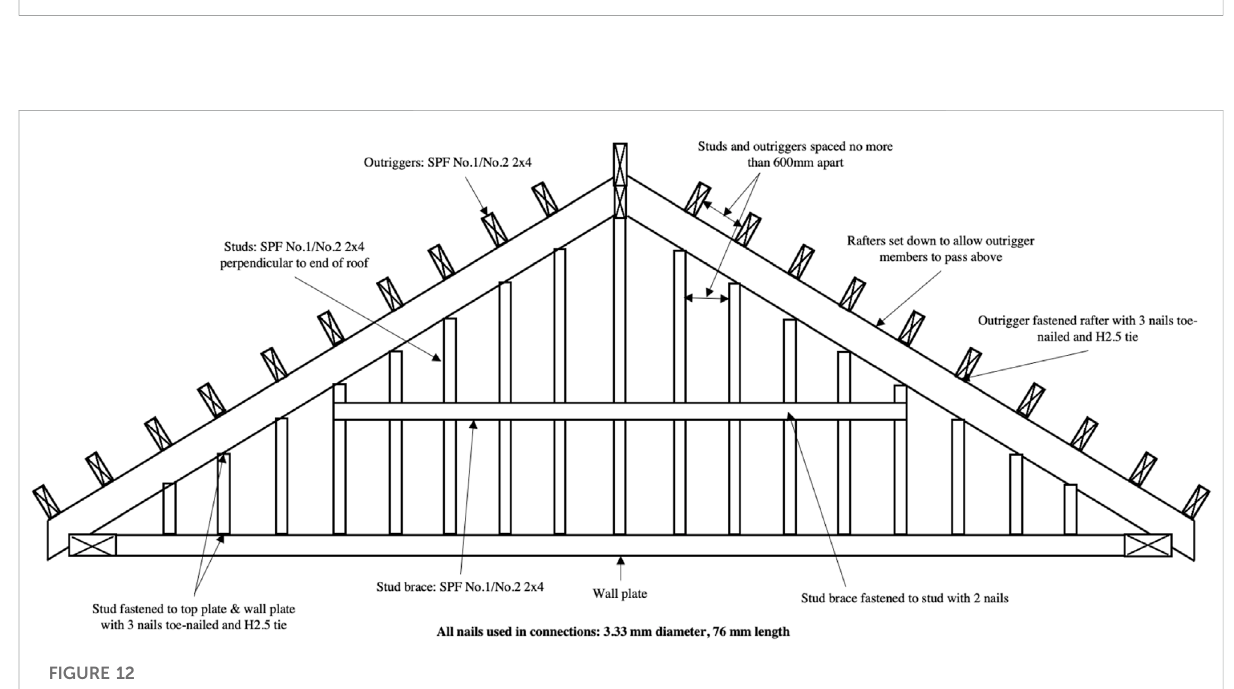
FIGURE 11 The recommended connections and members in the repeating inner frame.